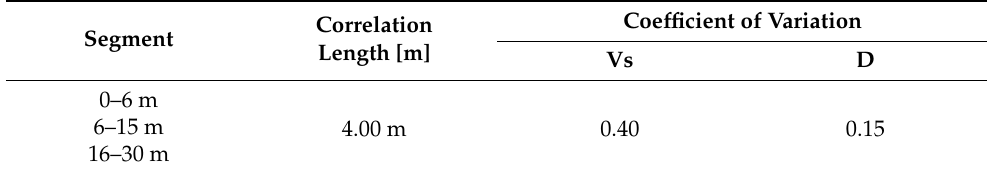
( b ) Figure 15. Probabilistic linear-equivalent soil behavior curves: ( a ) G- γ ; ( b ) D- γ .